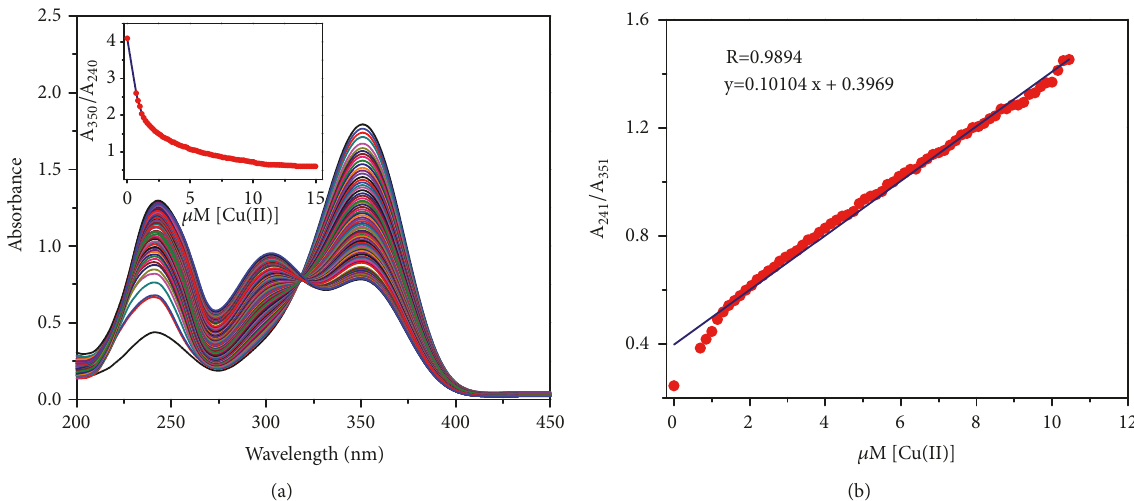
Figure 3: (a) Absorption spectral alterations of chemosensor BDC upon gradual addition of (0–2 equiv.) Cu(II); (b) the linear relationship of the absorbance ratio at 351 and 241 nm (A 241 /A 351 ) versus [Cu(II)].